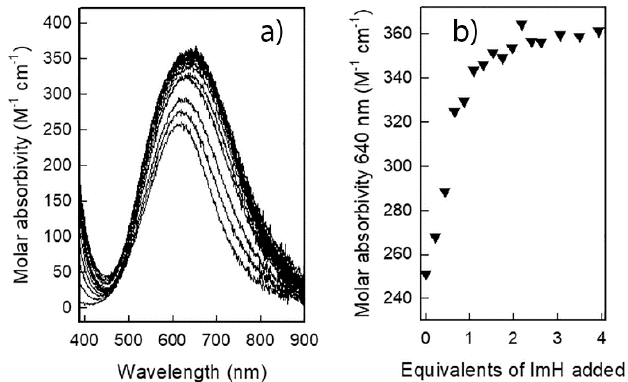
Figure 2. ( a ) Spectrophotometric titration of a [Cu 2 (BPXD)] 4+ solution (5 × 10 − 4 M, buffered at pH = 6.0 with MES) with imidazole; ( b ) Titration profile showing molar absorptivity at 640 nm (black triangles) vs. added imidazole equivalents respect to [Cu 2 (BPXD)] 4+ .